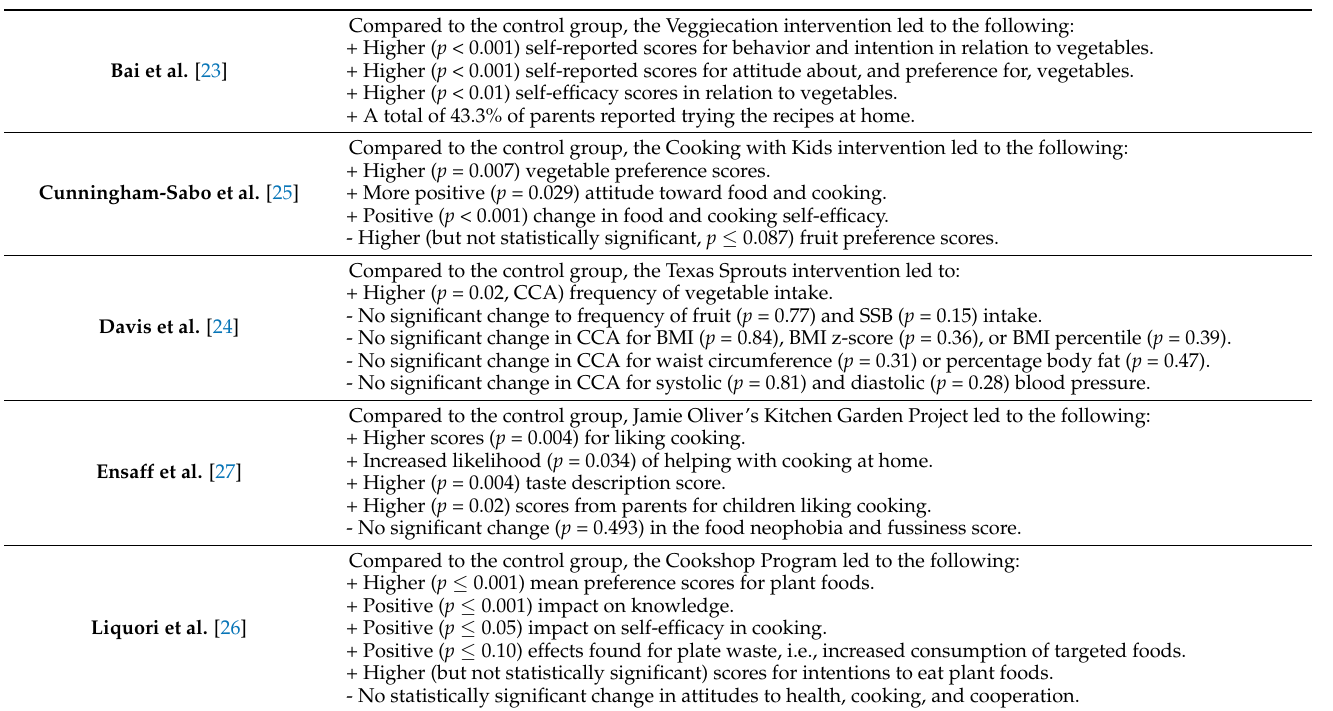
Table 2. Summary of key results from school-based culinary interventions for 5–12-year-old children.